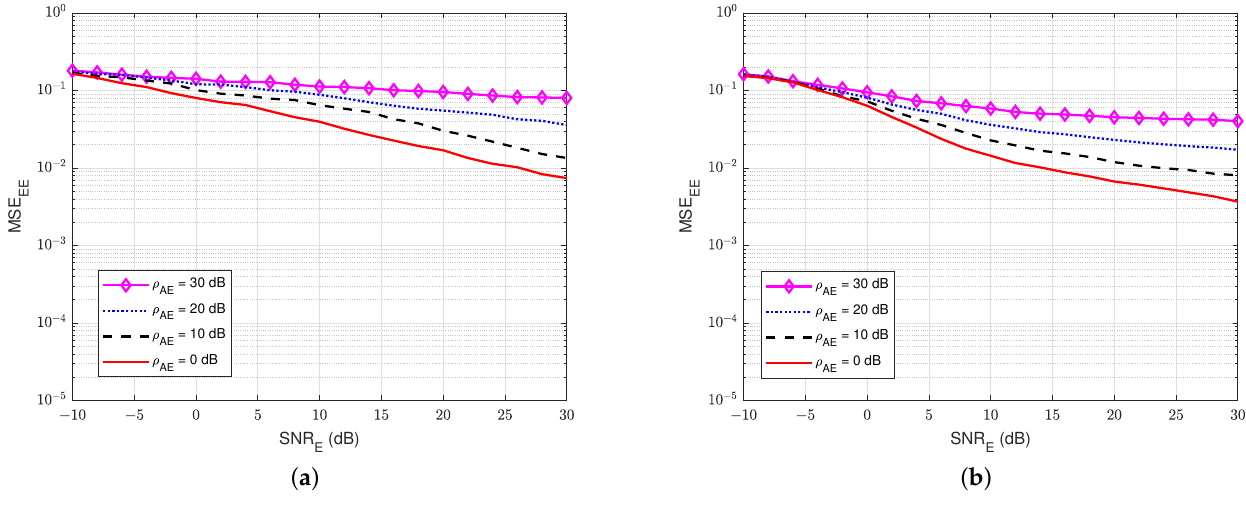
Figure 17. MSE EE versus SNR E , ρ EE = 30 dB in case of an active eavesdropper. ( a ) Blind without feedback; ( b ) Semi-blind without feedback.